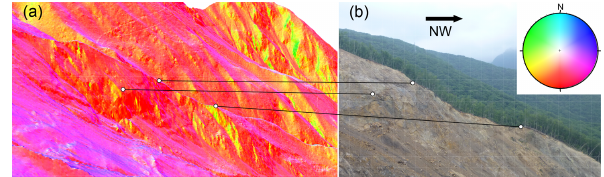
Figure 18. (a) Correlation of the orientations from ArcScene– COLTOP scenery (the colours of the normal to the topography are given in the lower hemisphere) and (b) a picture of the southwestern upper scar of the Akatani landslide.